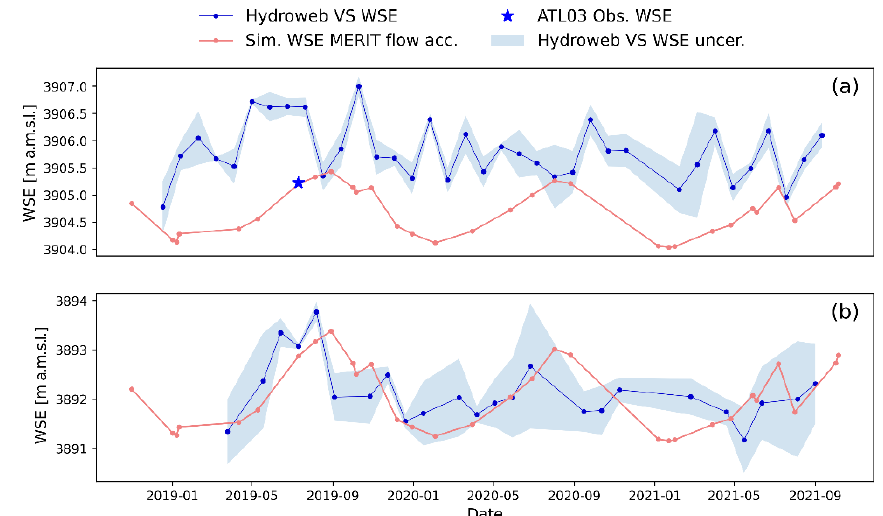
Figure 12. Comparison of estimated WSE with available Hydroweb VS in the area of interest (AOI). The WSE at VSs is derived from Sentinel-3A observations. (a) Simulated WSE at chainage 545030m vs. WSE at VS 4914km. (b) Simulated WSE at chainage 560360m vs. WSE at VS 4901km.